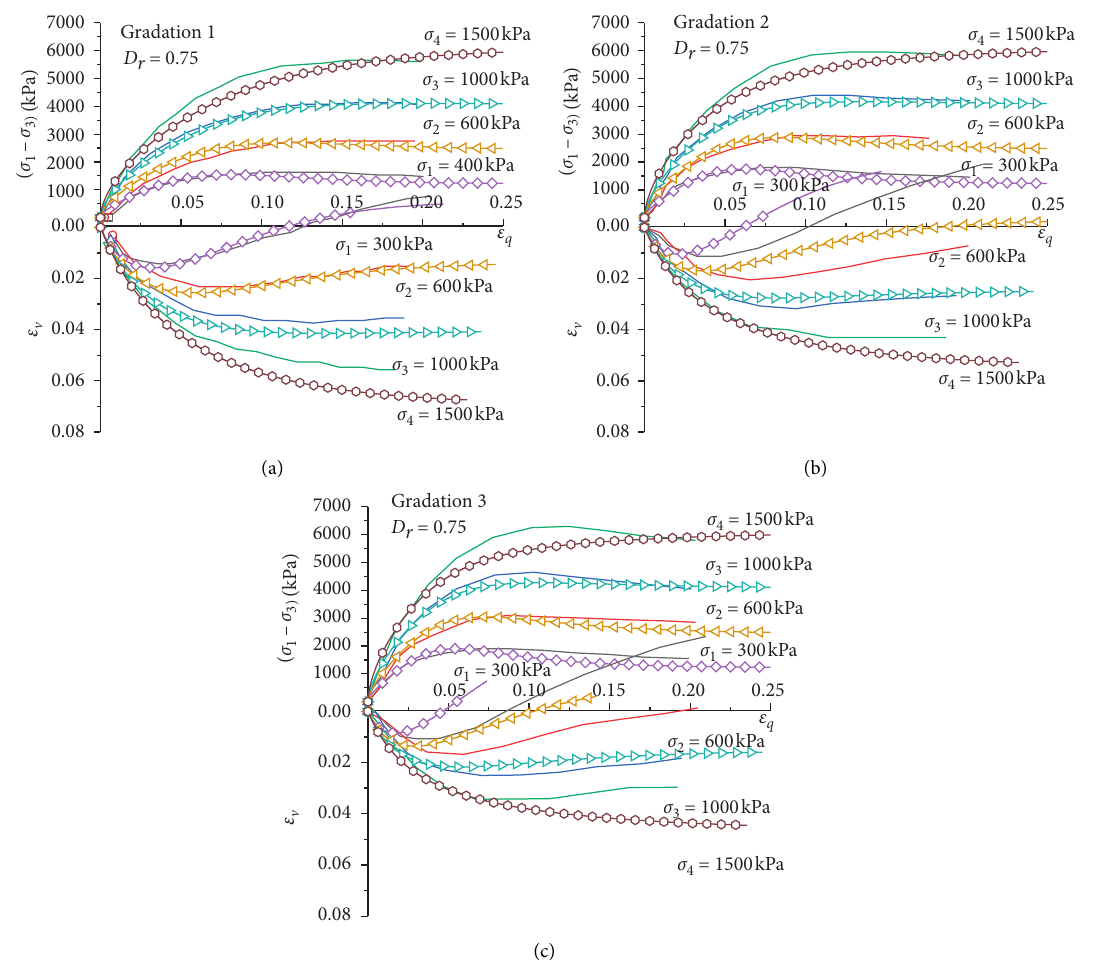
� 0.75). (a) Gradation 1. (b) Gradation 2. (c) Gradation r